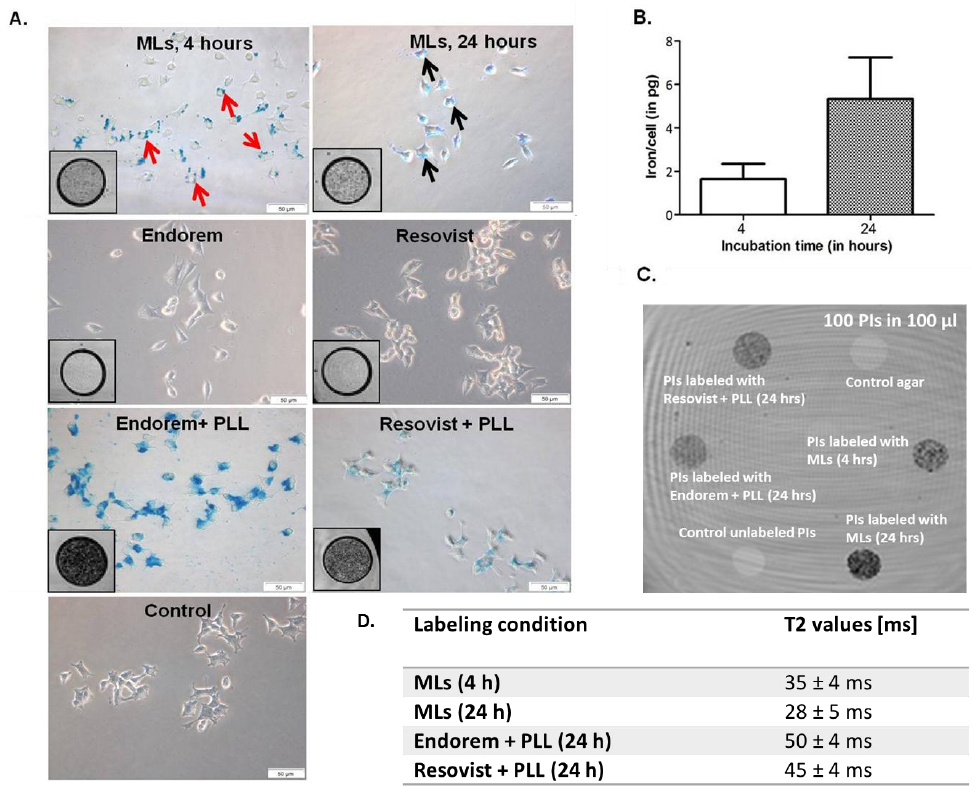
Figure 1. Iron uptake and confirmation of labeling: ( A ) Prussian Blue staining of INS-1E cells labeled with magnetoliposomes (MLs) at 50 µ g Fe/mL medium for 4 h indicates that MLs adhered on the cell membrane (red arrows), whereas longer incubation (24 h) resulted in particle uptake and prominent blue staining in the cell cytoplasm (black arrows). Prussian Blue staining of INS-1E cells labeled with Endorem and Resovist alone at 50 µ g Fe/mL medium for 24 h indicated no or only marginal uptake, whereas 100% of cells were labeled when superparamagnetic iron oxide particle (SPIOs) were conjugated with poly- L -lysin (PLL). Inserts in all Prussian blue-stained microscopic images show the T2*-weighted MR images for the different labeling conditions after 24 h of labeling. Hypointensity (dark contrast) represents the labeled cells. ( B ) Inductively-coupled plasma optical emission spectrometry (ICP-OES) measurements of INS-1E cells labeled with MLs showed a marked increase in iron uptake with increasing incubation time (1.64 ± 0.70 pg/cell at 4 h and 5.33 ± 1.9 pg/cell at 24 h) (Mean ± S.D.). Scale bar: 50 µ m. ( C ) T2-weighted MR image of agar phantom-containing labeled pancreatic islets (100 islets suspended in 100 µ L after labeling with Resovist + PLL, Endorem + PLL, and MLs. ( D ) T2-values acquired from the phantoms shown in ( C ).